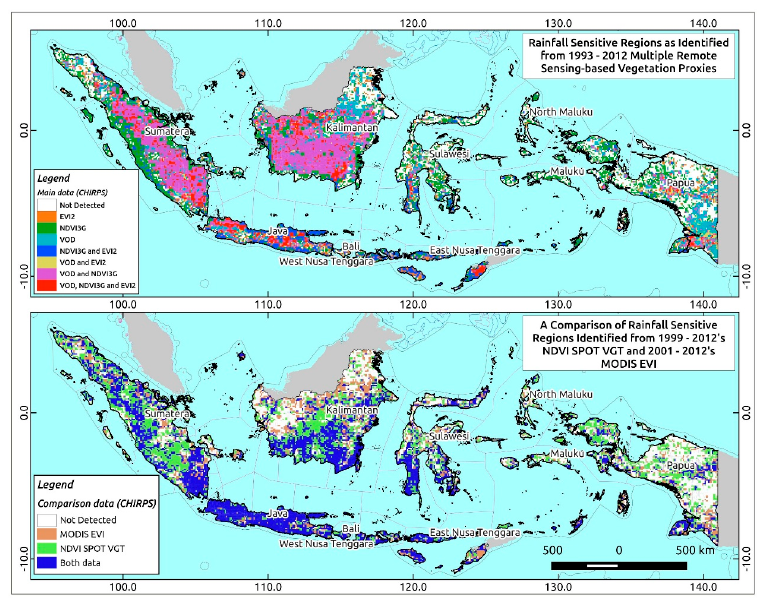
Figure 5. Rainfall-sensitive regions from primary data still show high agreement between VOD and NFVI3g indicated in purple color ( top ); and the spatial distribution of ancillary data is almost identical to the primary data ( bottom ).